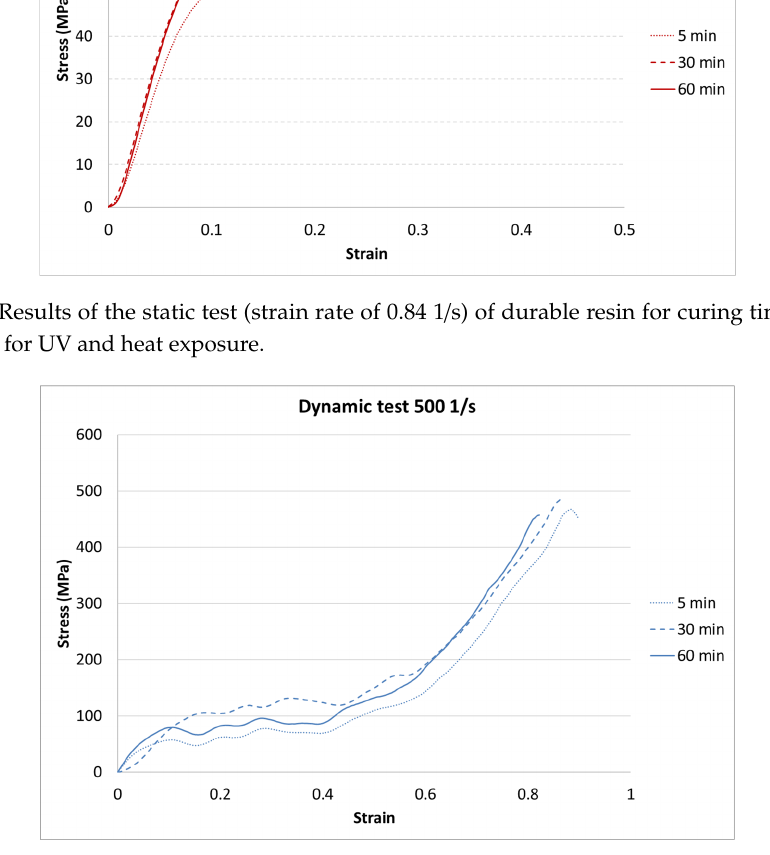
Figure 11. Results of the dynamic test (strain rate of 500 1/s) of durable resin for curing times of 5, 30, and 60 min for UV and heat exposure.